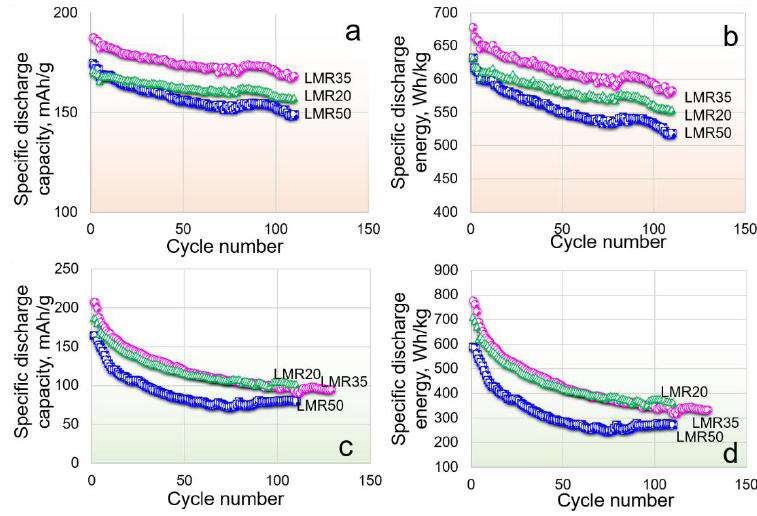
Figure 8. Cycling behavior of the materials in the range of ( a , b ) 2.5 – 4.3 V and ( c , d ) 3.0 – 4.8 V at 80 mA/g. The charge – discharge profiles and the dQ/dV curves in the 100th cycle for the three different voltage ranges are shown in Figure 9.